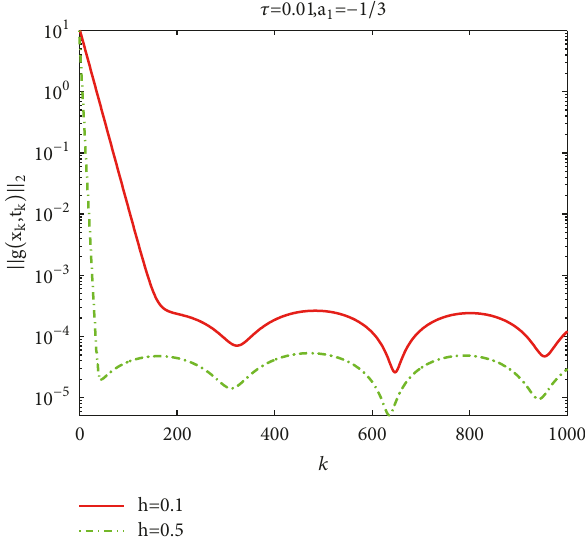
Figure 6: Trajectories of SSRE ‖𝑔(𝑥 𝑘 ,𝑡 𝑘 )‖ 2 generated by the DTZNN model (18) with different step-size for problem